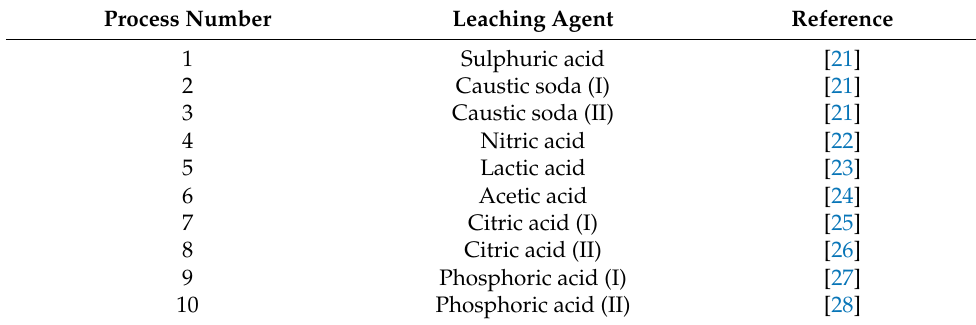
Table 1. Processes studied for Co extraction by means of different leaching